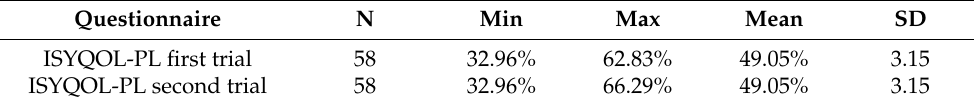
Table 1. Distribution of minimal, maximal, and mean total scores (%) of ISYQOL-PL. Questionnaire N Min Max Mean SD ISYQOL-PL first trial 58 ISYQOL-PL second trial 58